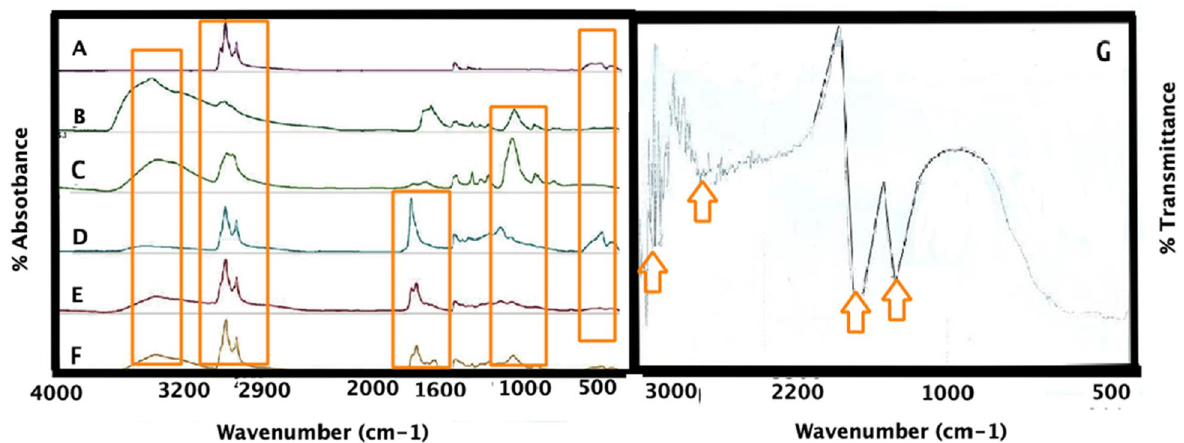
Figure 2. Comparison of the FT-IR spectra of ( A ) Fe 3 O 4 @ A. sativum ( B ) Fe 3 O 4 @ A. sativum /CS/PLA/PU; ( C )